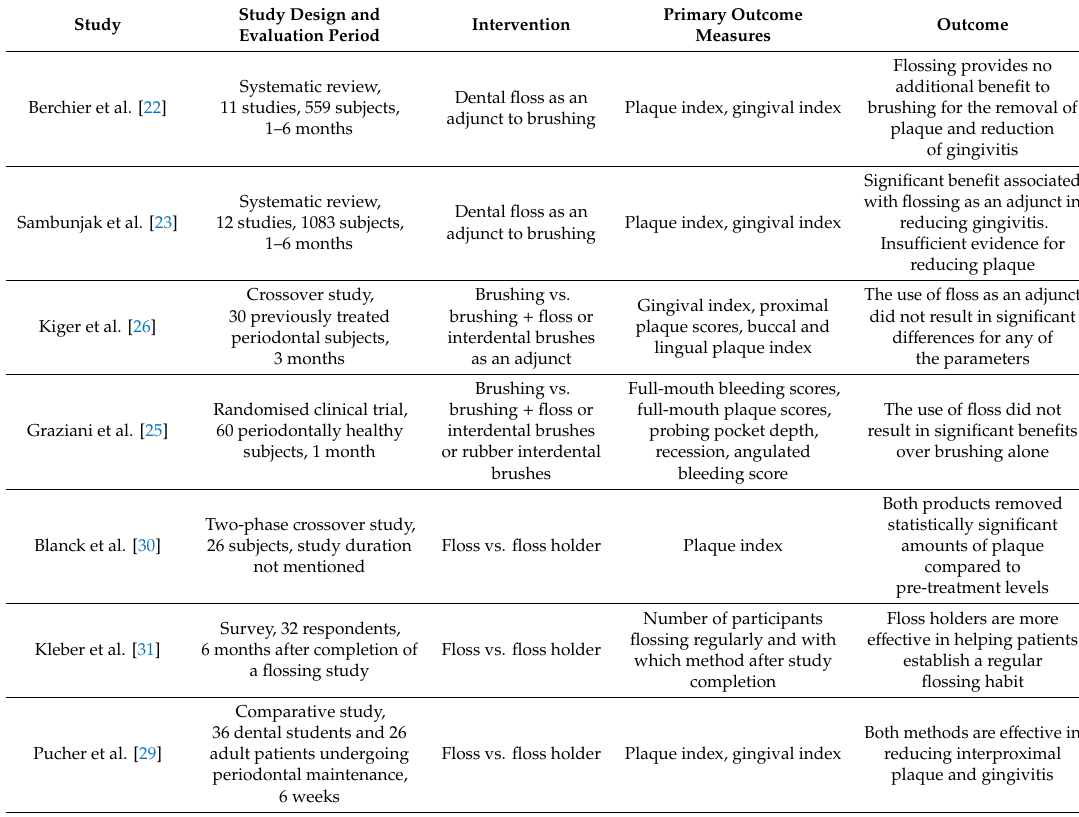
Table 1. Summary of included studies on the e ff ectiveness of